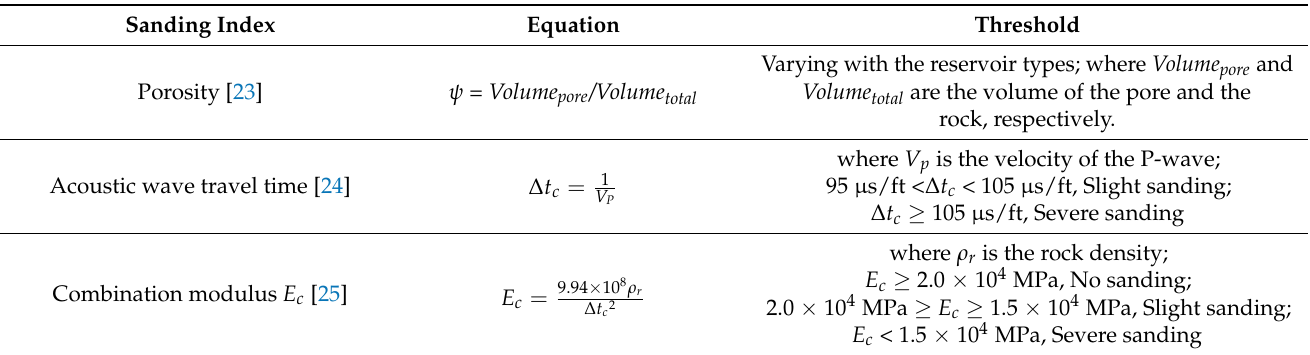
Table 1. Index of sanding risk of reservoirs in the